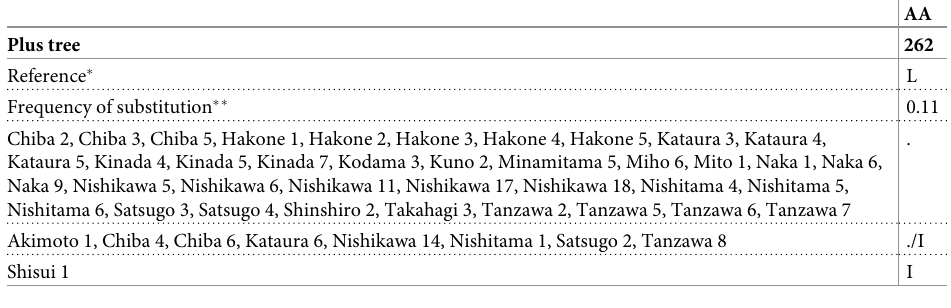
.: without substitution;–/I: both the reference and substituted residue ‘I’ were deduced; I: substitution was deduced. � Amino acid residue in mature form of Cha o 1 is shown. �� Frequencies of substituted residues for the 47 plus trees are